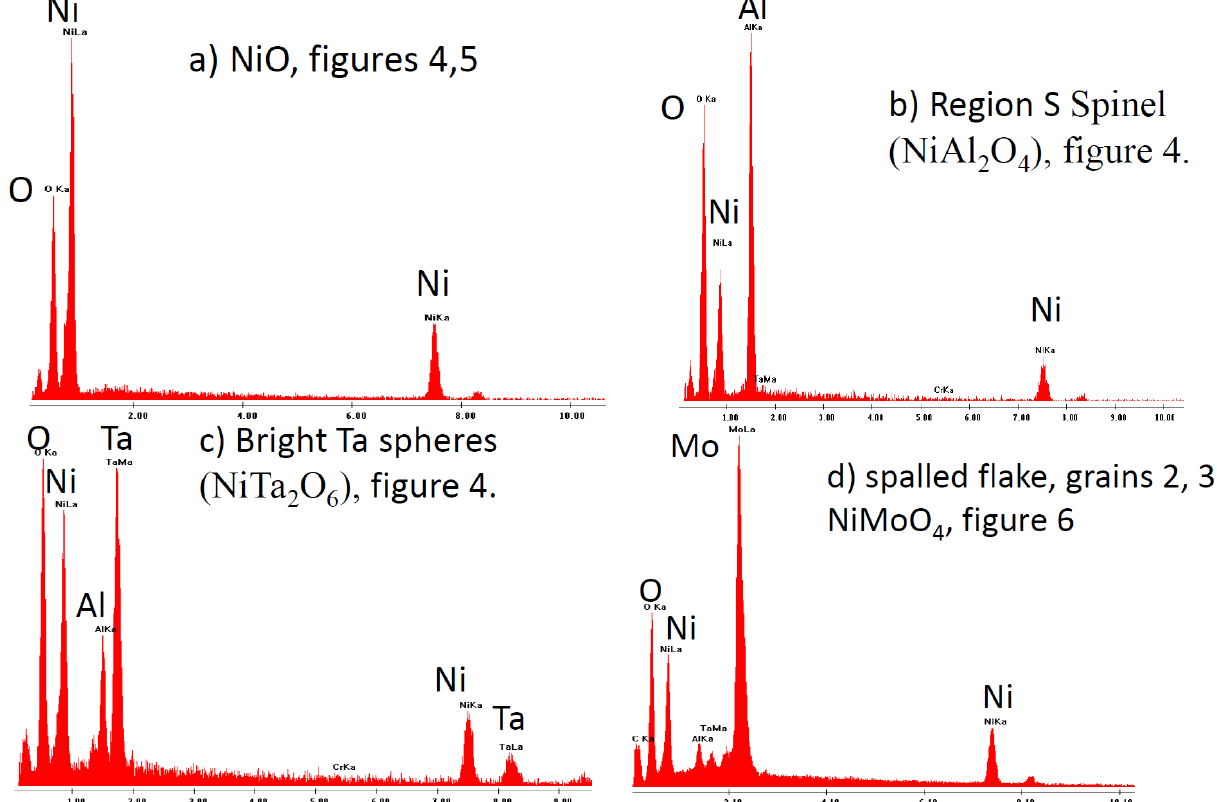
Figure 7. Typical EDS profiles corresponding to representative Ni-, Al-, Ta-, and Mo-rich features for high 12% Mo (0010) alloy 2-48, 200 h cyclic oxidation at 1100 °C. ( a ) large, striated NiO grains (Figure 5a); ( b ) flat NiAl 2 O 4 plateau (Figure 4); ( c ) bright NiTa 2 O 6 topmost spheroids (Figure 4); and ( d ) underlying NiMoO 4 grains from spalled flake (Figure 6), respectively.